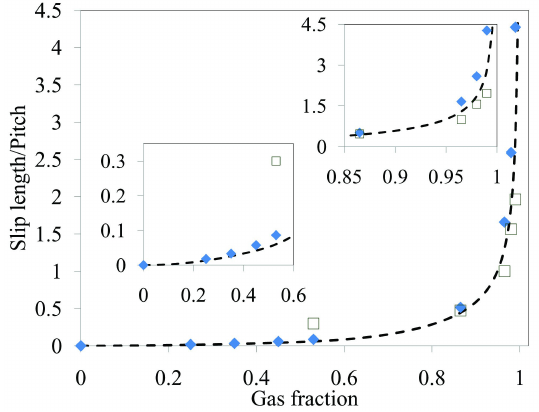
Figure 22. Slip length versus gas fraction obtained for laminar flow over ordered microposts superhydrophobic surface. Experimental data of Lee et al. [6] (open squares), theory of Ybert et al. [83] (dashed line), and numerical results of Samaha et al. [79] (solid diamonds).